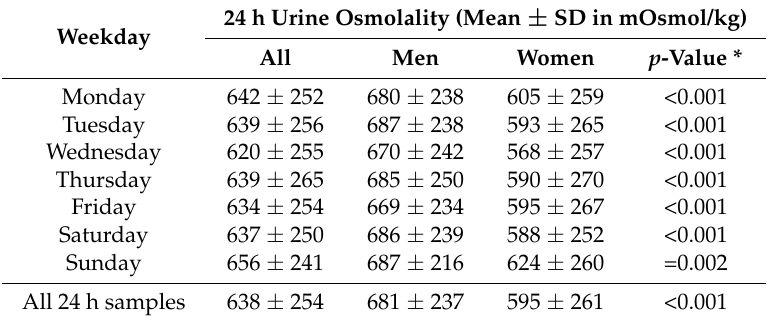
Table 2. Mean 24 h urine osmolality (mOsmol/kg) on weekdays for men and women.